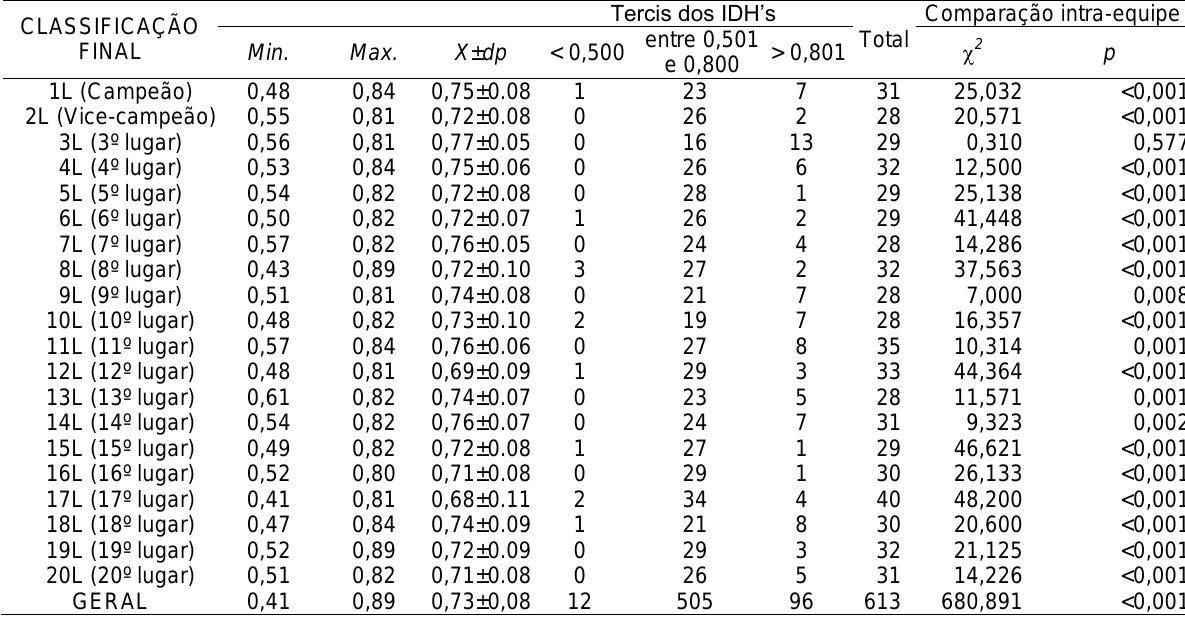
Tabela 2. Valores mínimos, máximos e médios dos Índices de Desenvolvimento Humano das equipes e as suas frequências nos três intervalos de classificação.